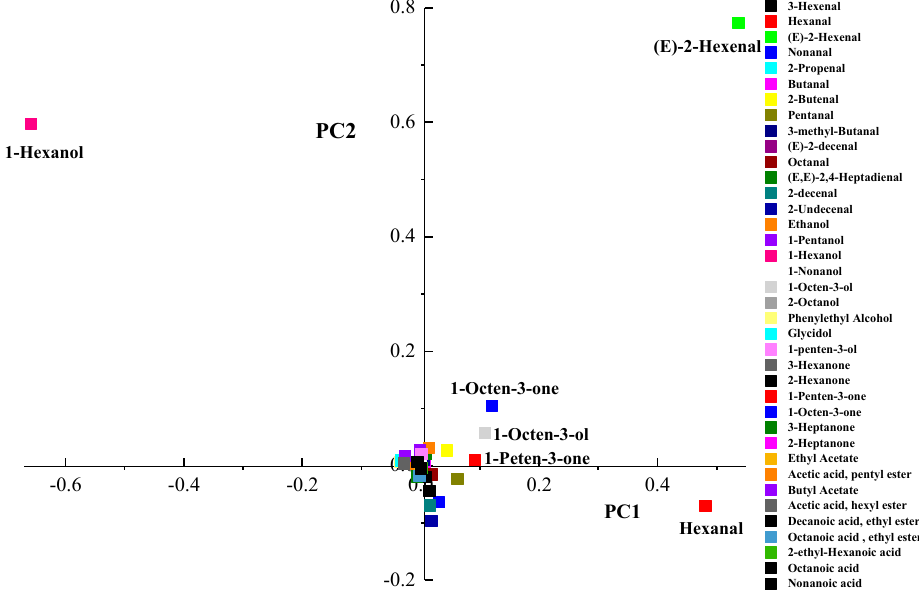
Figure 4. Loading plots after principal components analysis of the variables in the plane defined by the two first principal components (PC 1 and PC 2).